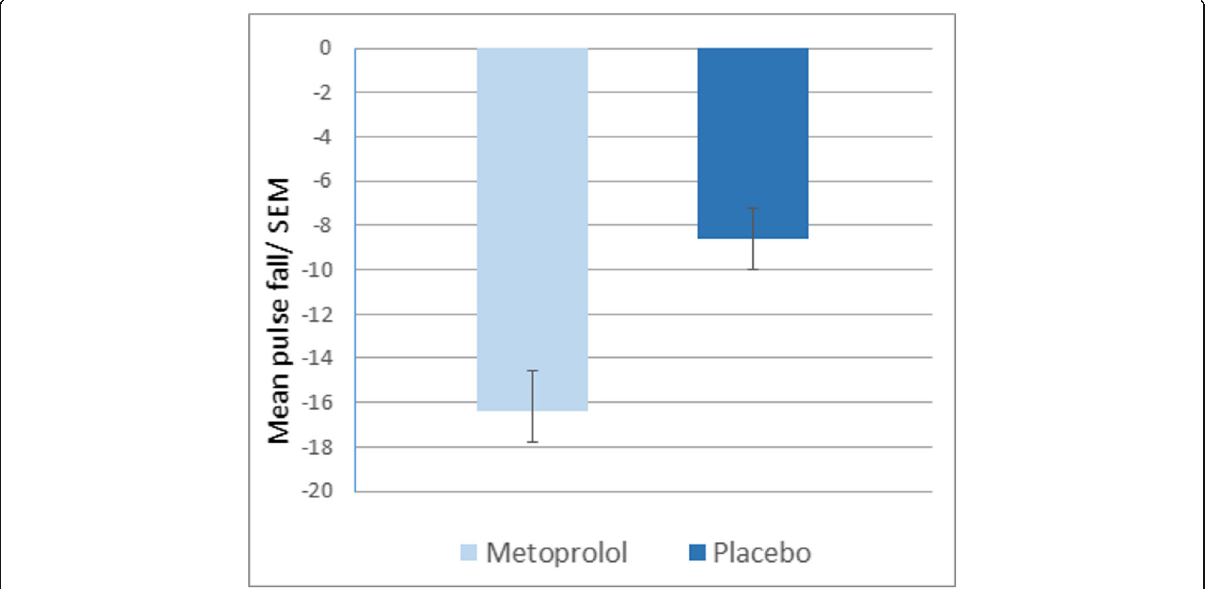
Fig. 3 Pulse under metoprolol and placebo in healthy subjects. Pulse of the subjects were measured at two time points in each session and subtracted afterwards (pulse change = T2 [after experimental paradigm] - T1 [before treatment]). The pulse drop in the metoprolol session is significantly bigger than in the placebo session ( p <